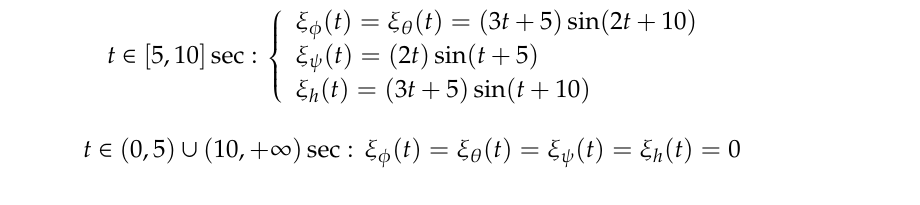
Table 2. System parameters of the quadcopter for